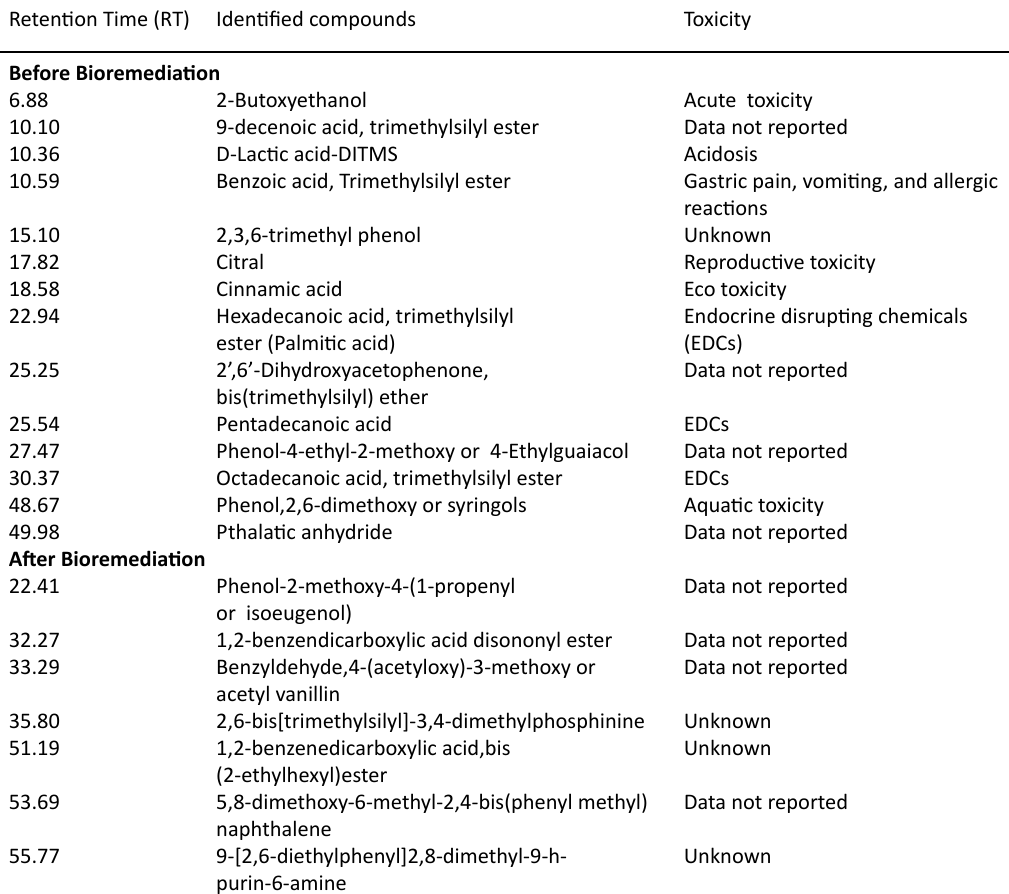
Table 2. Identified residual organic pollutants by GC-MS analysis in the TMS derivatized ethyl acetate extracts of pulp paper industry effluent Retention Time